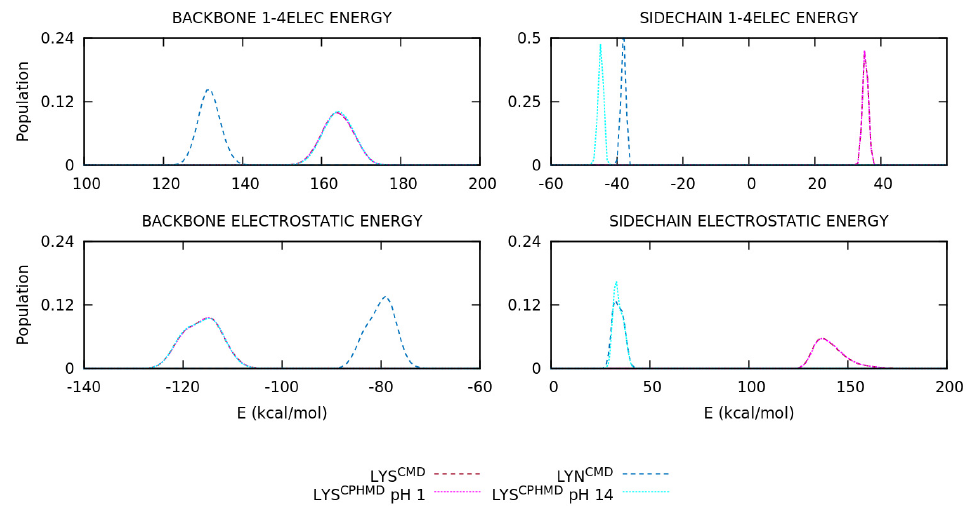
Figure 8. Energy distribution of the 1–4 and long-range electrostatics of the backbone and side chain atoms of the blocked Lys 2 tripeptide. Dotted and dashed lines are CPHMD and CMD simulation methods, respectively.